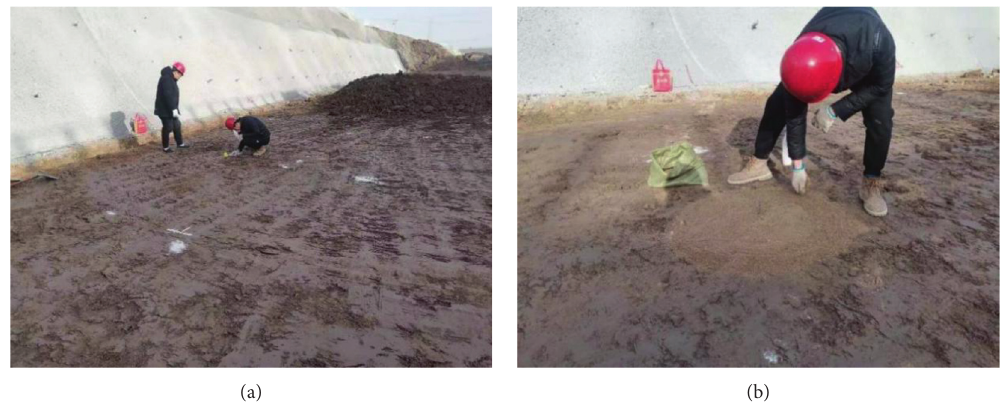
Figure 2: Positioning (a) with medium coarse sand leveling